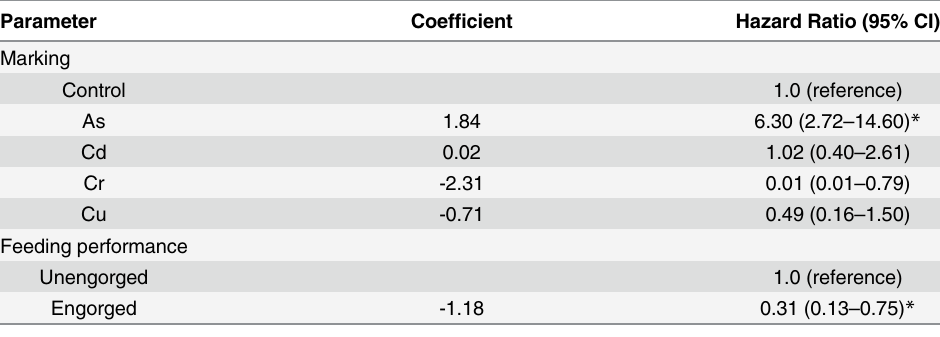
Table 3. Associations between Triatoma brasiliensis trace element marking and feeding performance or